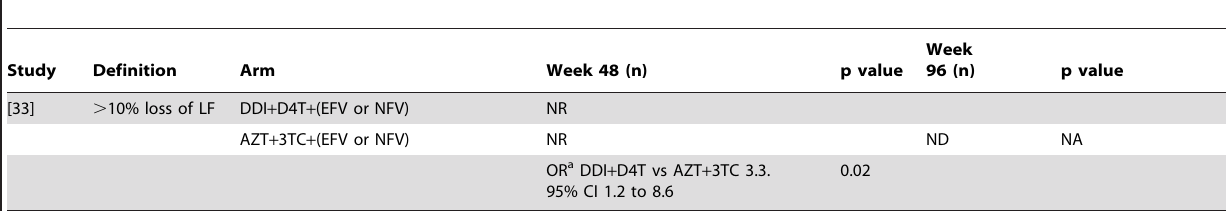
Table 9. Proportion of patients with peripheral lipoatrophy on DEXA scan: NRTI versus NRTI.